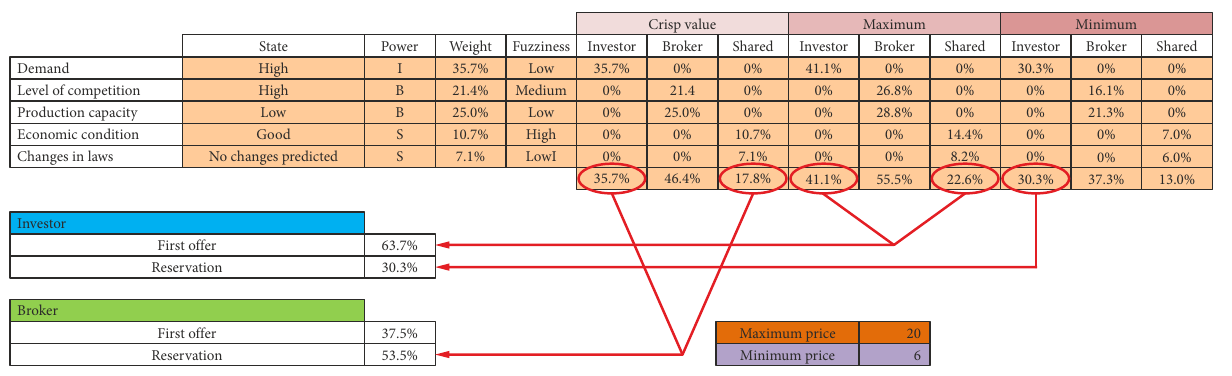
Figure 2. An example